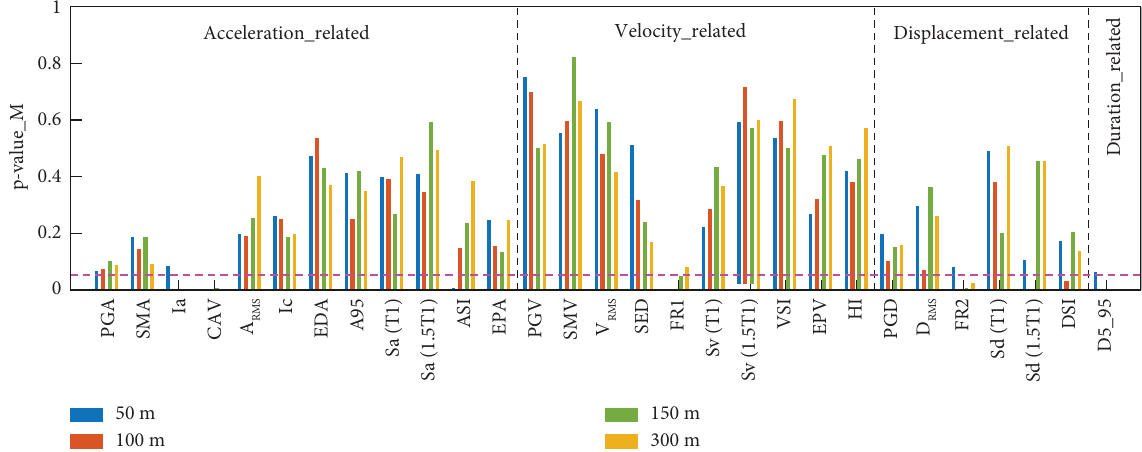
Figure 13: Sufciency comparison of 29 candidate IMs against M for the slopes with diferent mining depths.